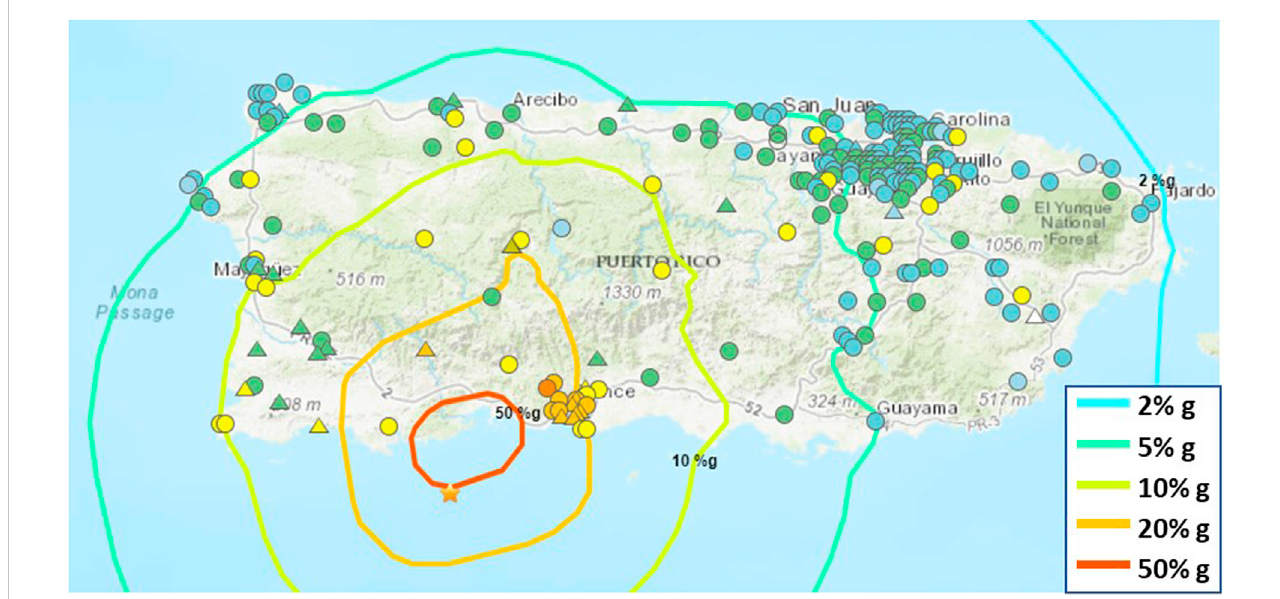
FIGURE 3 PGA contours estimated from ShakeMap for 7 January 2020, M w 6.4 earthquake (USGS, 2020).